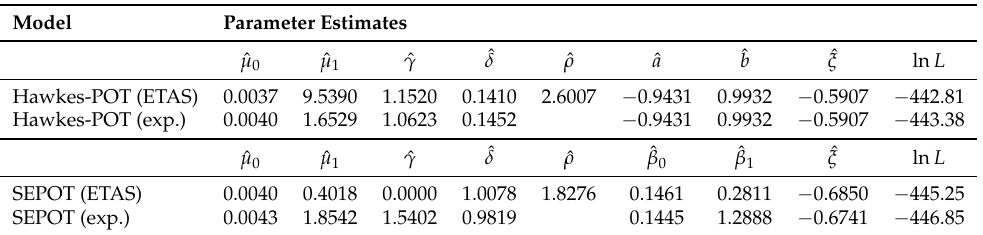
Table 1. Estimation results of the Hawkes-POT and SEPOT model. Italic numbers represent bounds of the estimation